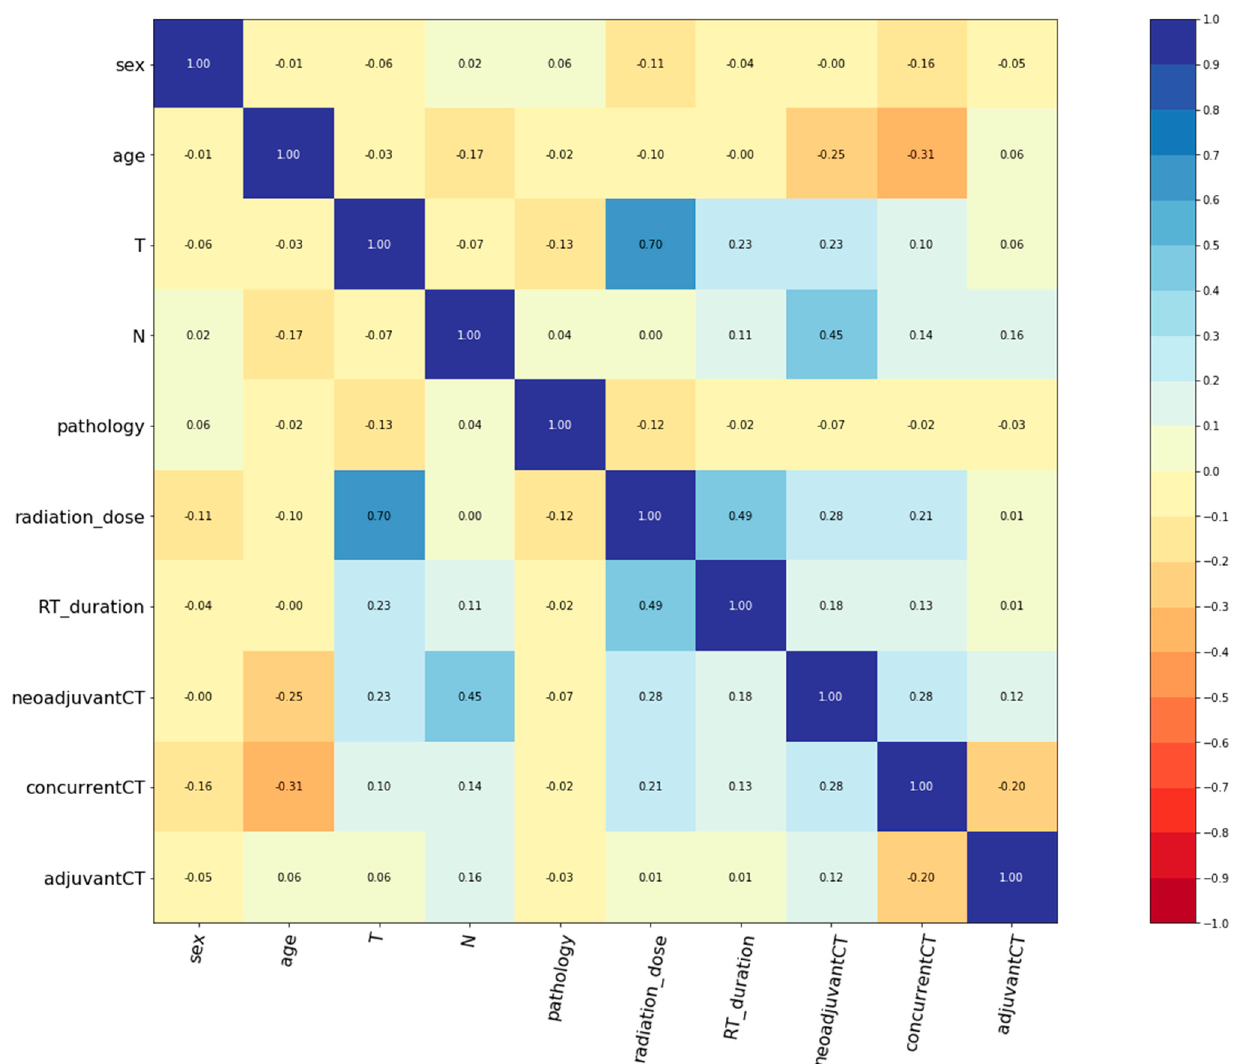
Figure 1. Correlogram illustrating the correlation between all variables. CT, chemotherapy; RT, radiotherapy.